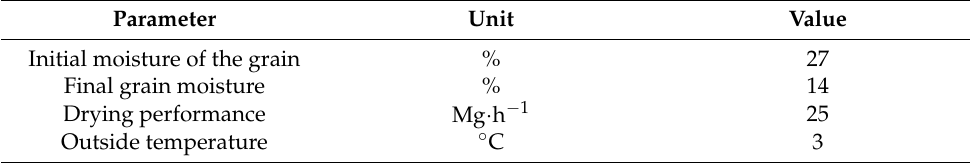
Table 10. Working conditions of the S428.CS dryer.